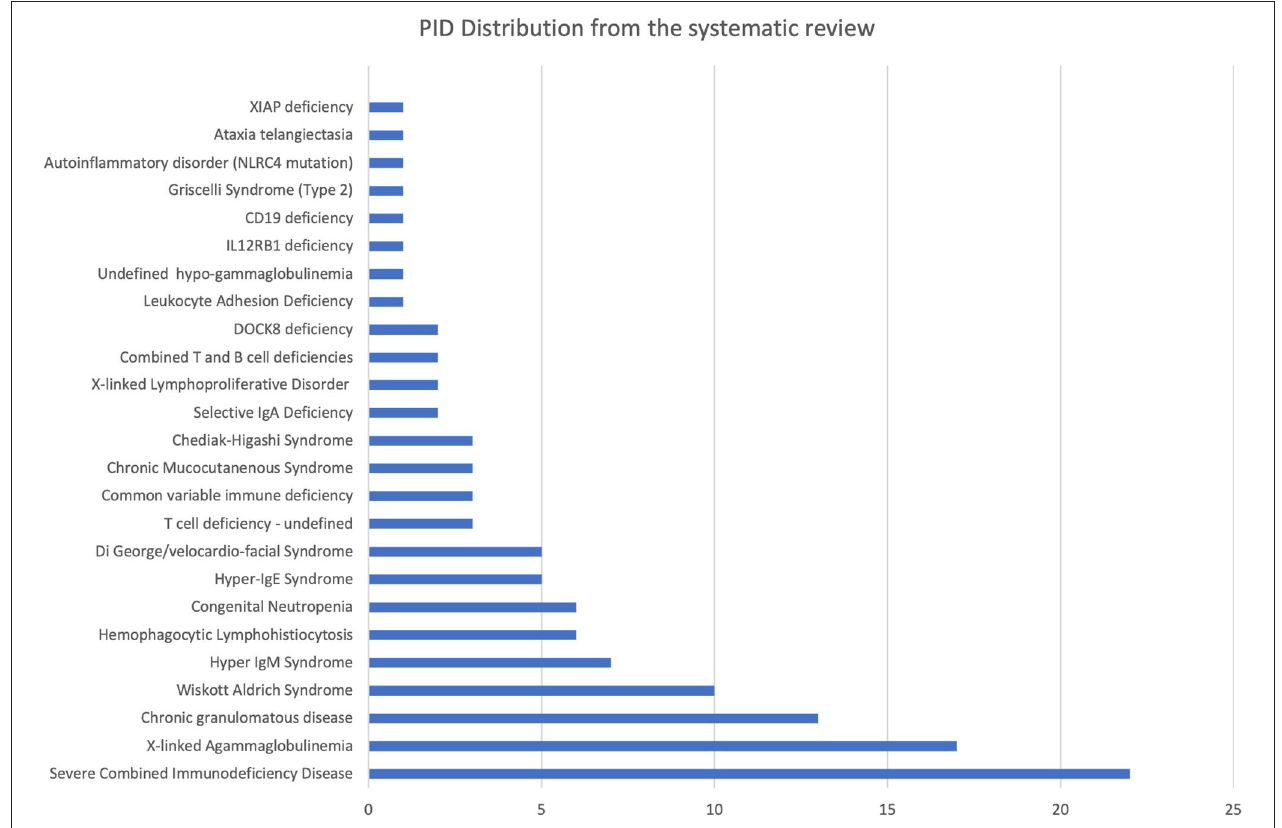
FIGURE 2 | PID diagnosis distribution identified from systematic